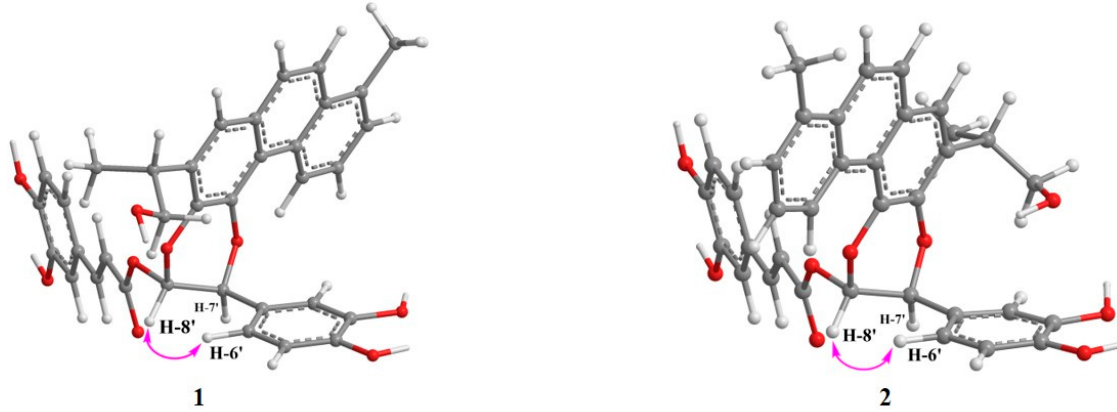
Figure 3. Energy-minimized structures of compounds 1 and 2 with Key ROE correlations.